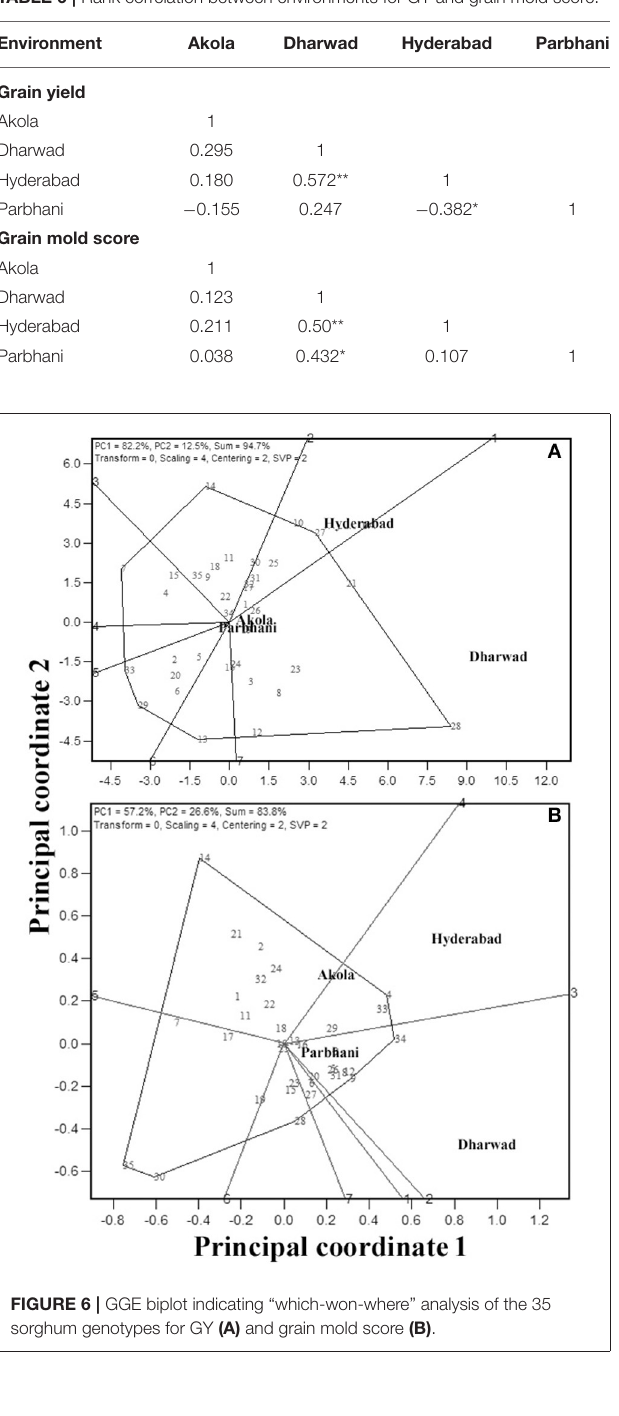
TABLE 6 | Rank correlation between environments for GY and grain mold score. Environment